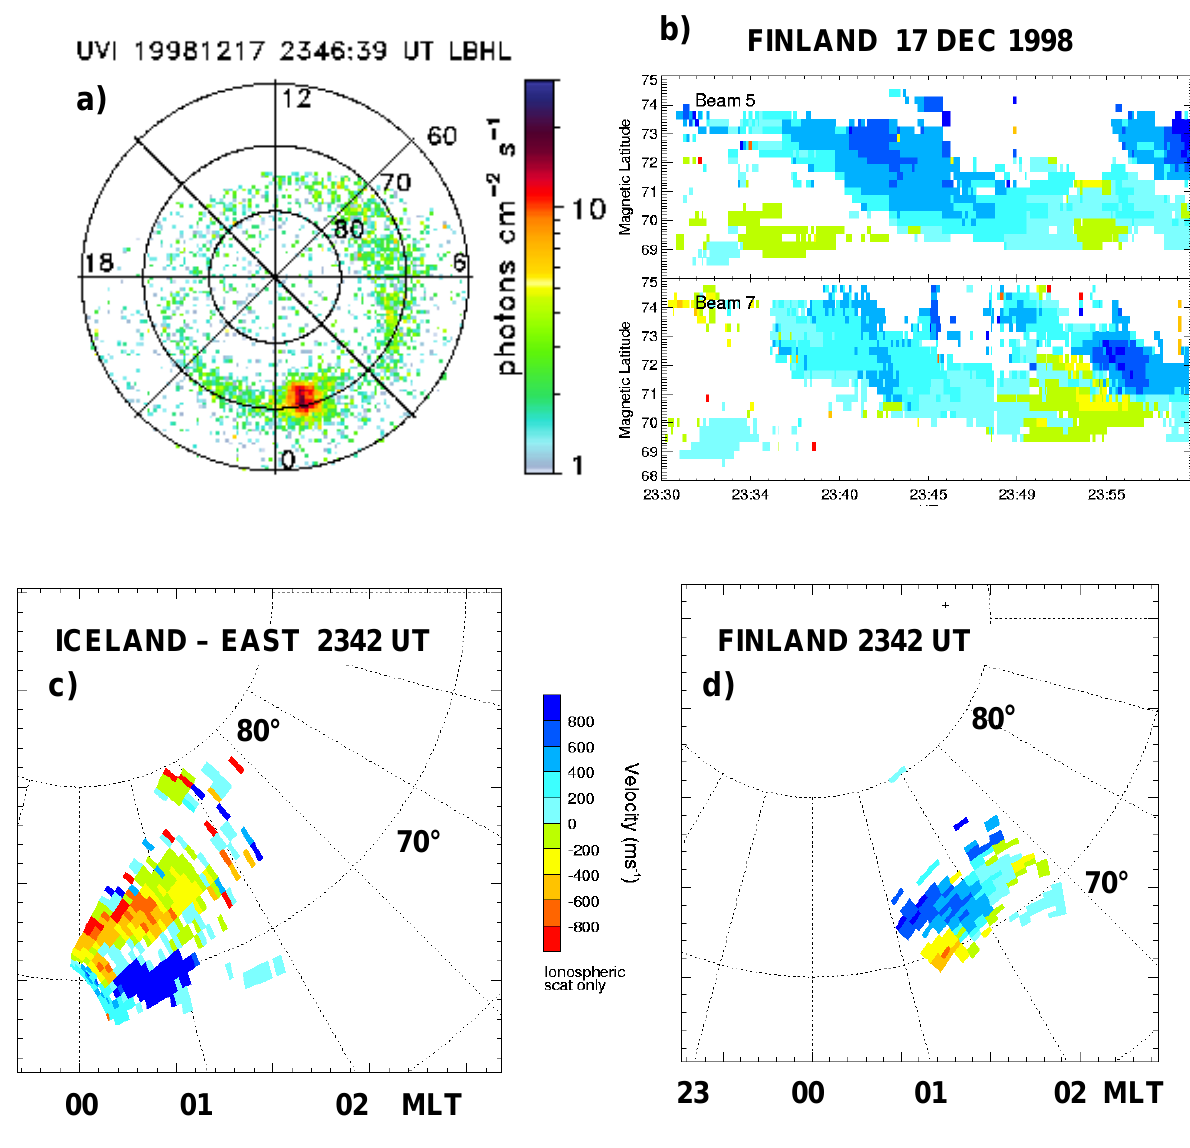
Fig. 7. The clockwise vortical flow around an auroral bright spot. (a) POLAR UVI auroral image. (b) The range-time plot of the radial velocity from beams 5 and 7 of the Finland radar. (c) The radial velocity map from the Iceland-East radar. (d) The radial velocity map from the Finland